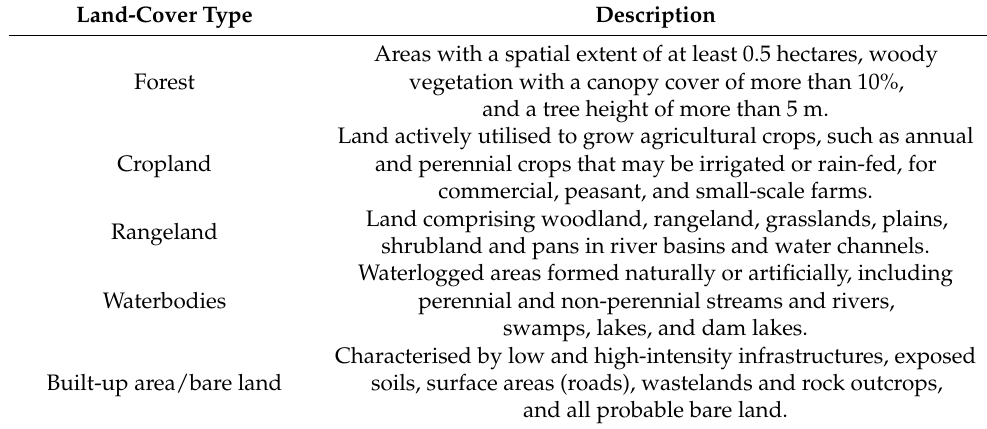
Table 2. Land-cover classes used in the study. Land-Cover Type Description Areas with a spatial extent of at least 0.5 hectares, woody Forest vegetation with a canopy cover of more than 10%, and a tree height of more than 5 m. Land actively utilised to grow agricultural crops, such as annual Cropland and perennial crops that may be irrigated or rain-fed, for commercial, peasant, and small-scale farms. Land comprising woodland, rangeland, grasslands, plains, Rangeland shrubland and pans in river basins and water channels. Waterlogged areas formed naturally or artificially, including Waterbodies perennial and non-perennial streams and rivers, swamps, lakes, and dam lakes. Characterised by low and high-intensity infrastructures, exposed Built-up area/bare land soils, surface areas (roads), wastelands and rock outcrops, and all probable bare